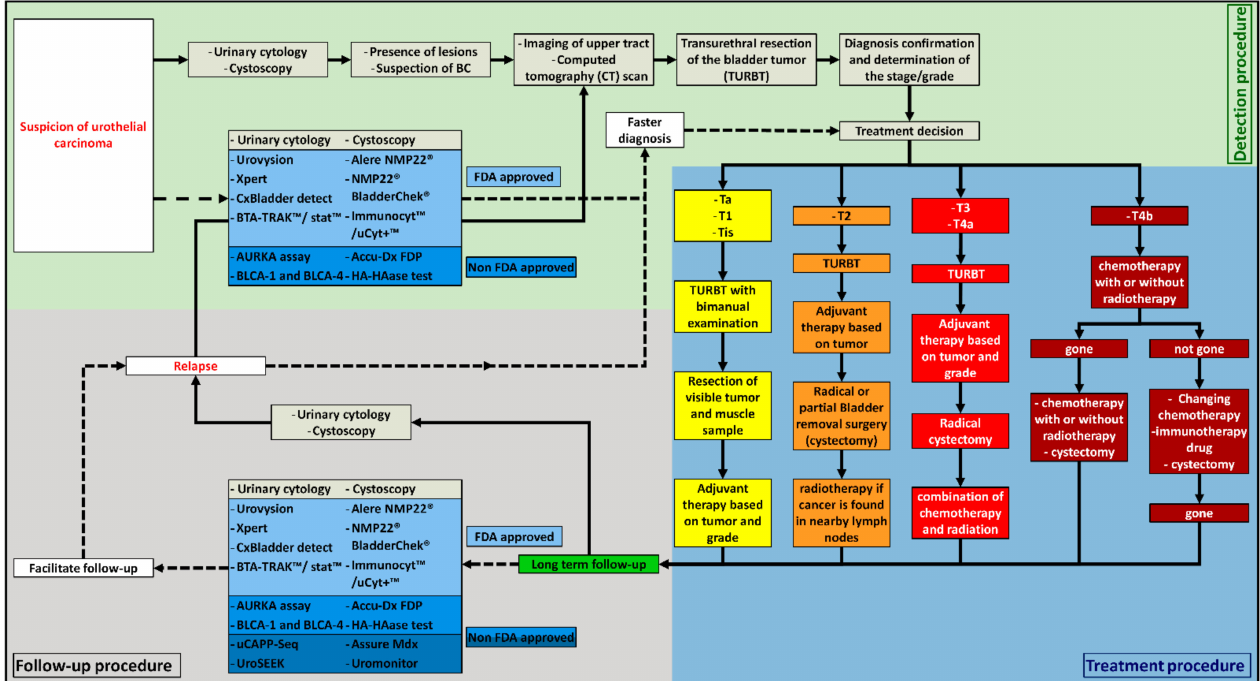
Figure 2. The different ways of detection, diagnosis, treatment, and follow-up of BC, depending on the clinical situa- tion. ————: Classical routine used by the clinicians nowadays; − − − − − : new methods that can be used by the clinicians